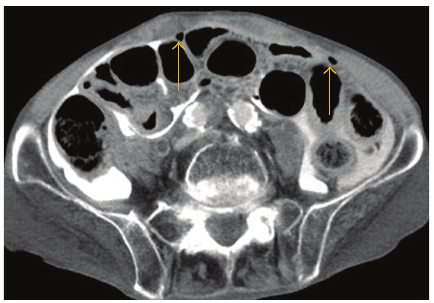
Figure 1: Computed tomography image showing thickening of the urinary bladder wall.